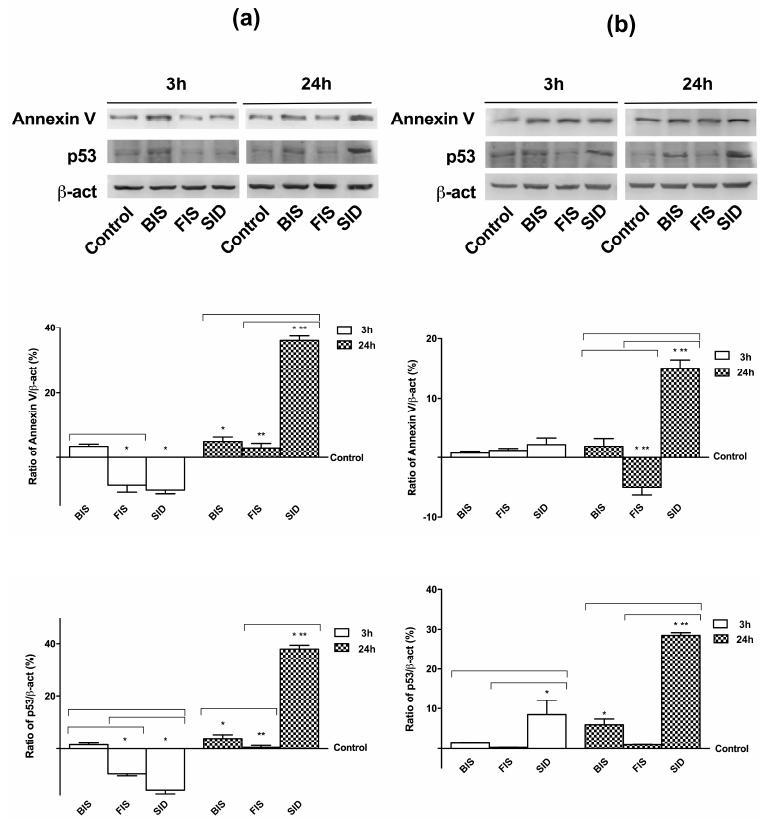
Figure 3. Western blot and densitometric analysis of Annexin V and p53 on GTL-16 ( a ) and Caco-2 cells ( b ) treated with different iron formulations at 3 h and 24 h. Western blot (upper) and densitometric analysis (down) are reported. The results after normalization through β -act and control, are expressed as means ± SD (% vs. control) of four independent experiments for each cell type. * p < 0.05 vs. control (reported as line); ** p < 0.05 vs. correspondent column at different time; bars p < 0.05 among different treatments at the same time.